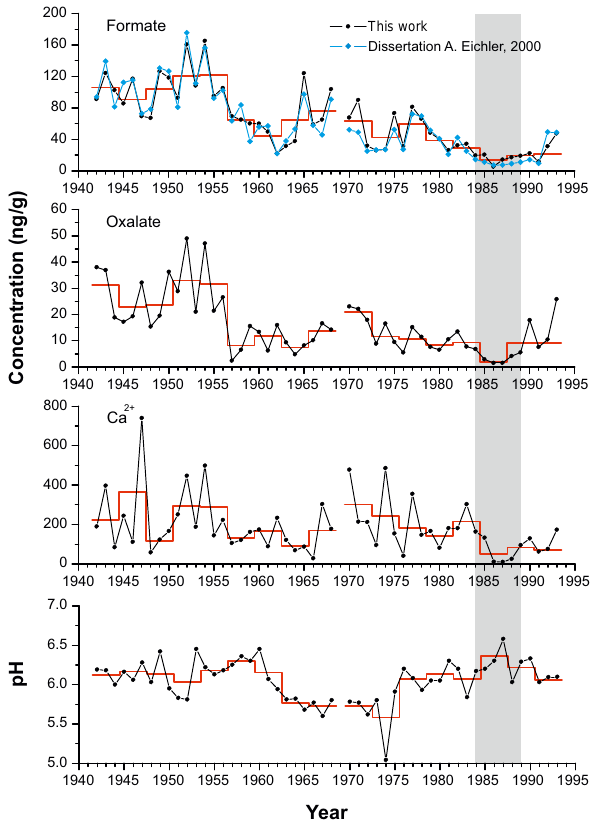
Figure 2. Ice core records of oxalate, formate, calcium, and pH (black dots: annual averages, red line: 3-year averages). The pe- riod influenced by meltwater (1984–89) is marked in gray. The ice core record of formate obtained from previous high-resolution mea- surements (blue diamonds, annual averages based on 2148 measure- ments, Eichler, 2000) fits well with the record determined using the 1-year sampling